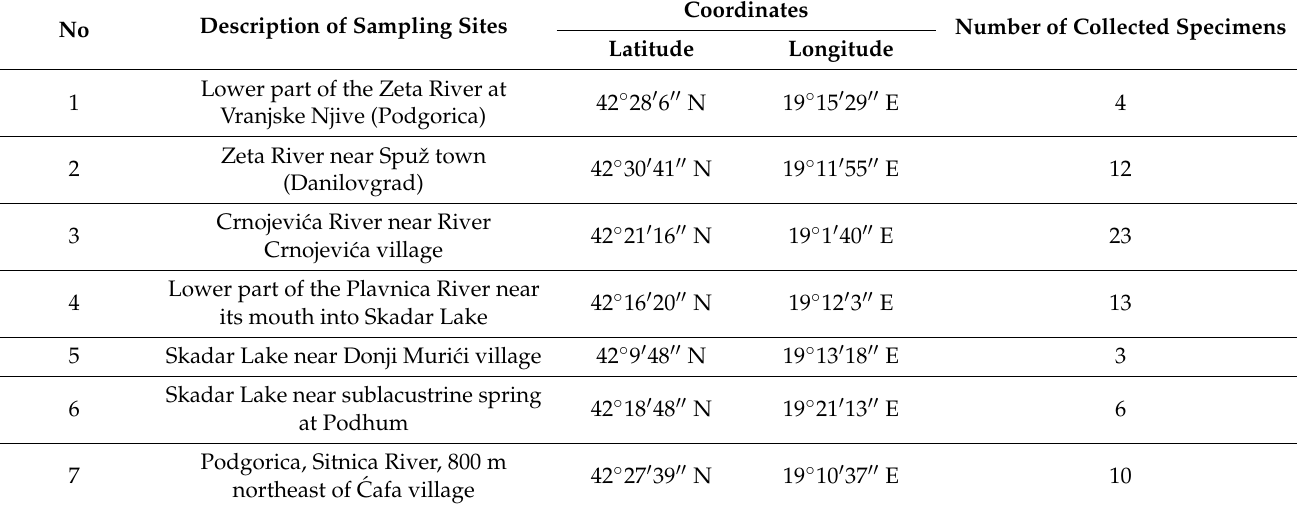
Table 1. List of studied localities in